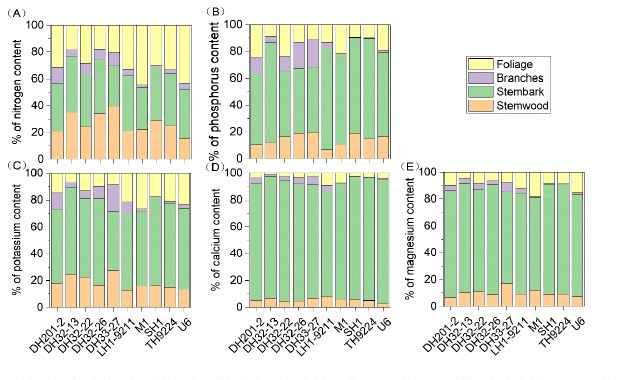
Figure 6. Nutrients distribution patterns among various tree components for ten Eucalyptus Clones. ( A ) Nitrogen contents, ( B ) phosphorus contents, ( C ) potassium contents, ( D ) calcium con- tents, ( E ) magnesium contents.